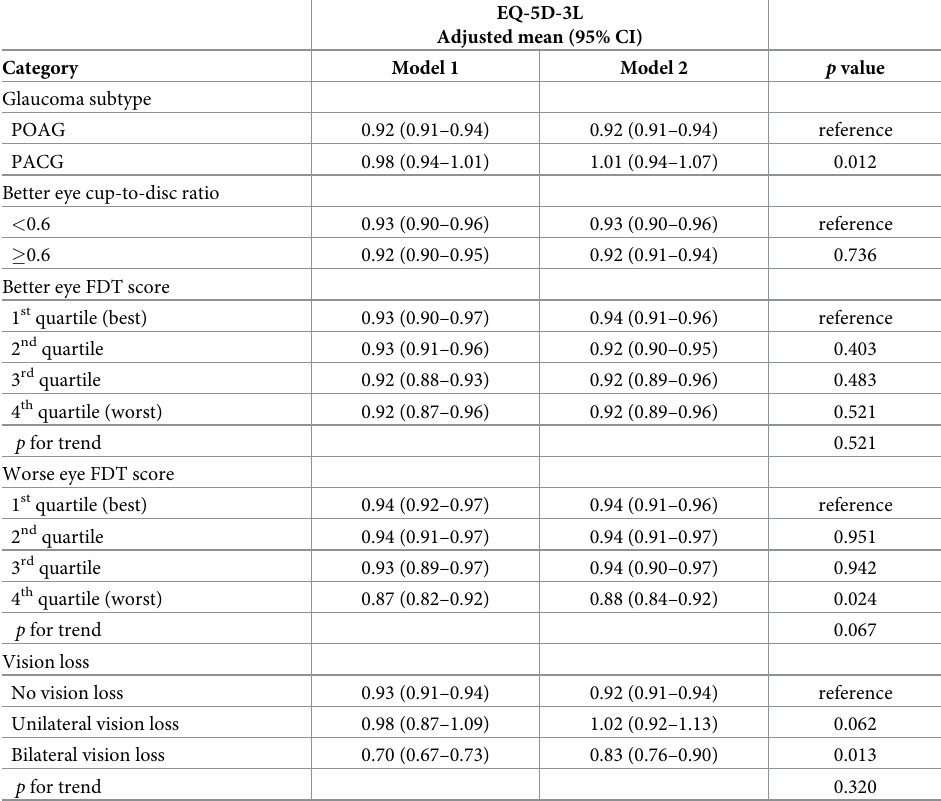
Table 3. Utility values according to glaucoma subtype, better eye cup-to-disc ratio, FDT score, and vision loss.